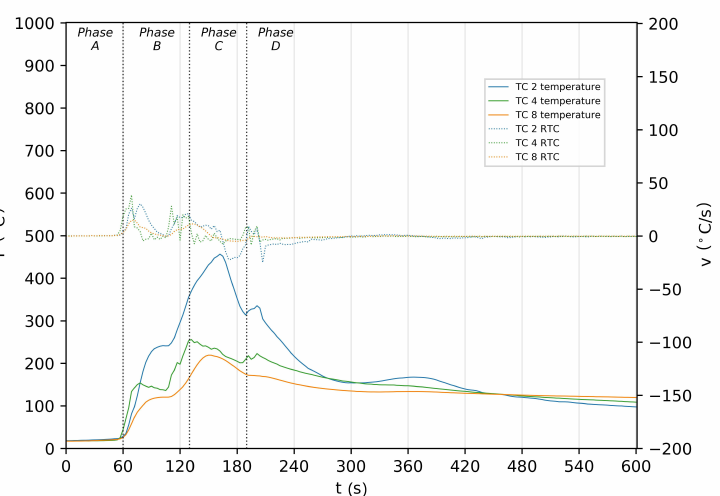
Figure 6. Temperature and RTC readings of TC3, TC5, TC7, and TC9 in the first 600 s of the test. Phases A, B, C, and D according to Table 2 and Figure